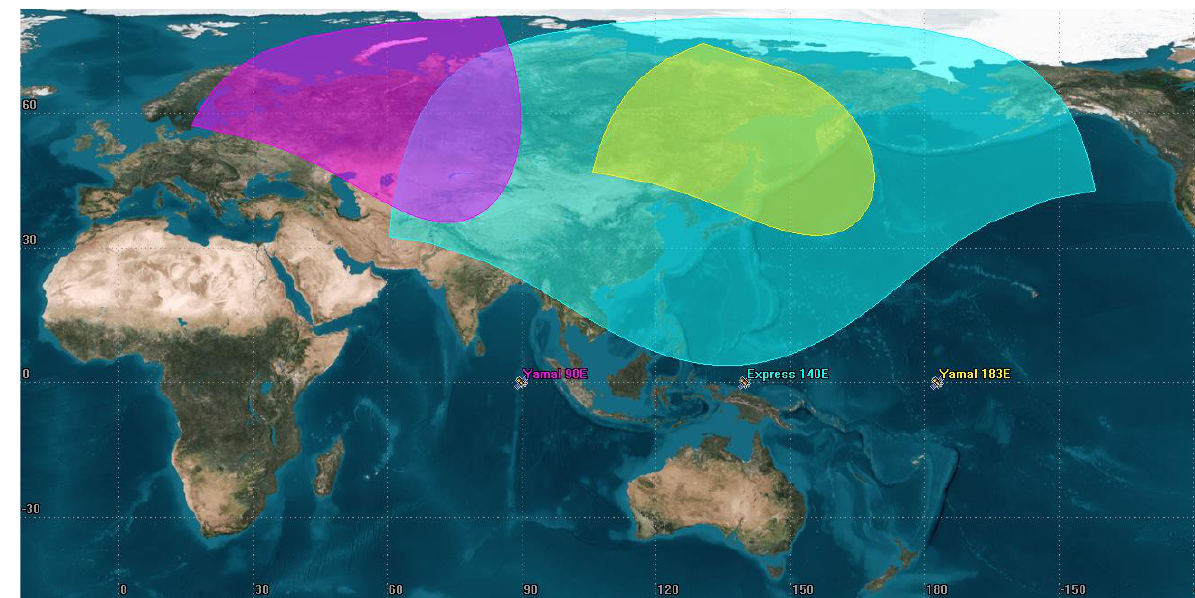
Figure 3. Satellite footprints of the reviewed FSS victim receivers. Table 2. Characteristics of 5G base stations used in